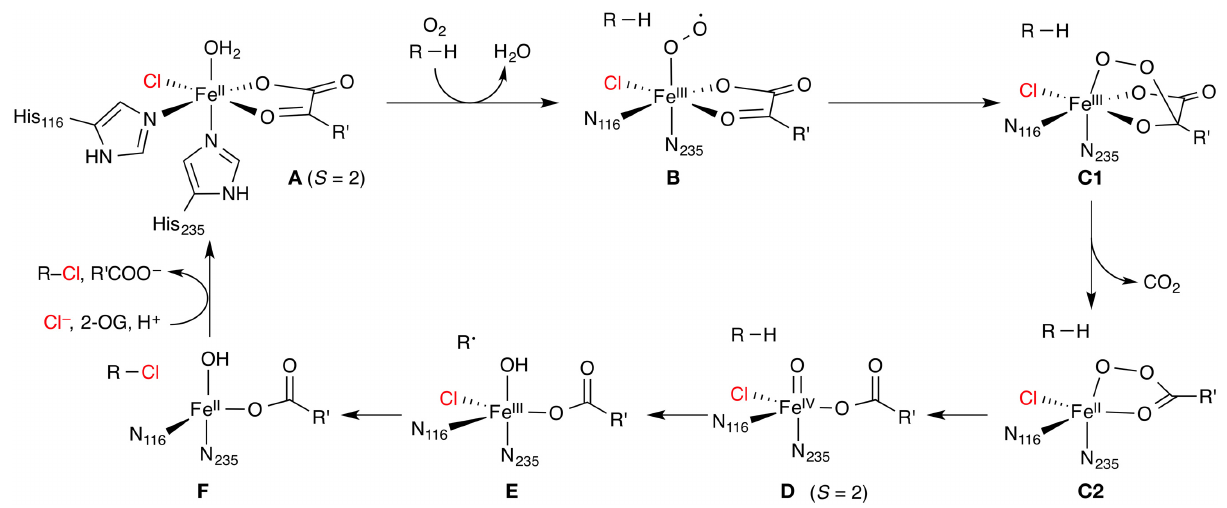
Frontiers in Chemistry | Theoretical and Computational